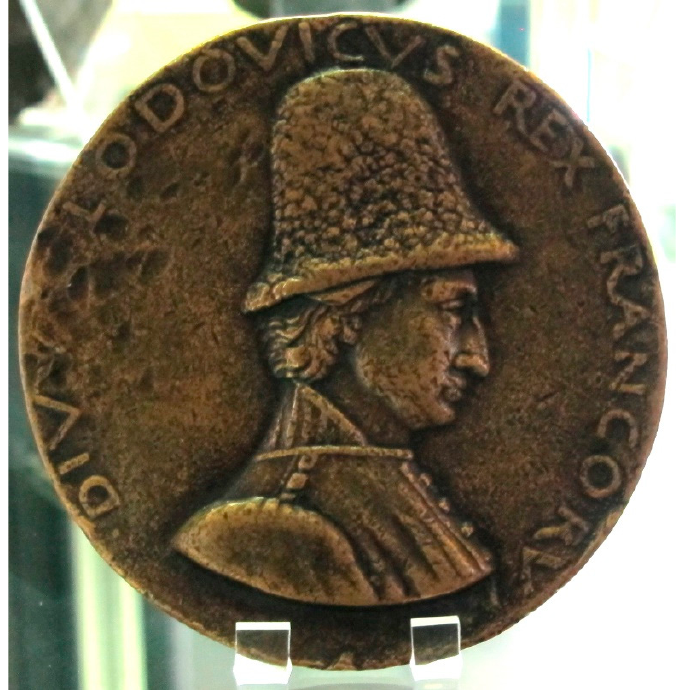
Figure 2. Francesco Laurana, Portrait medal of Louis XI (obverse), gilded bronze, 1465, Paris, Biblio-